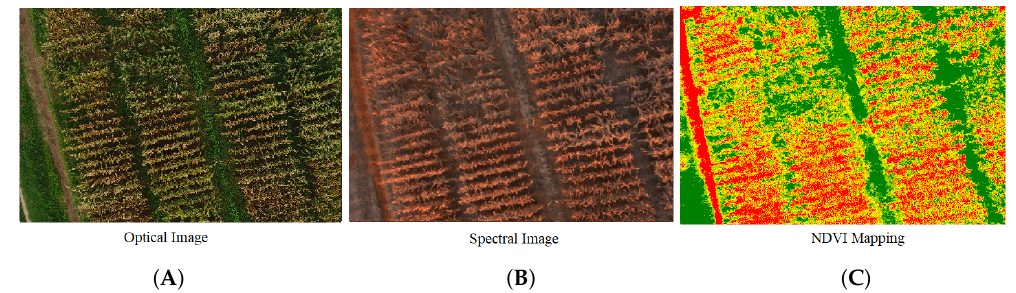
Figure 8. Maize crop. ( A ) Optical image; ( B ) spectral image; ( C ) NDVI